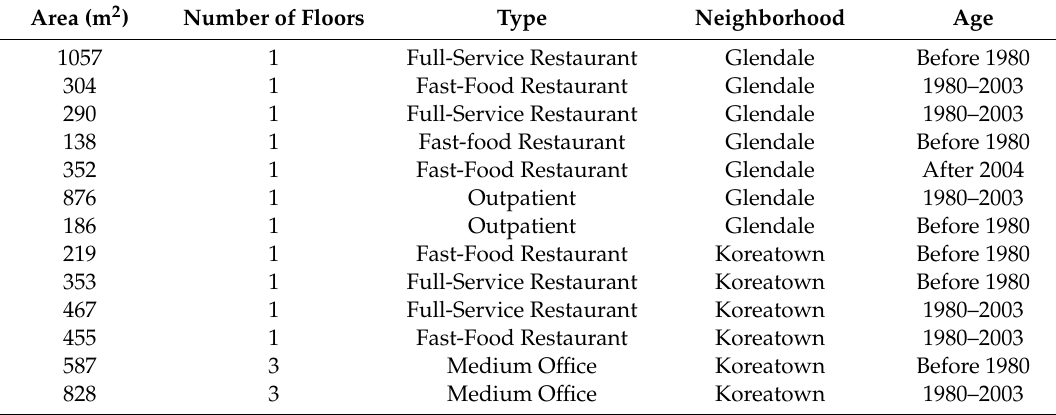
Table 2. Selected buildings for performance evaluation of PV-green roof mitigation e ff ects on potential building energy